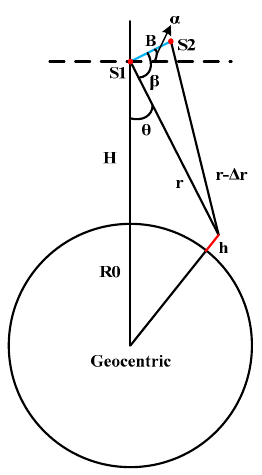
Figure 1. Schematic of the interferometric radar altimeter (IRA) geometry.